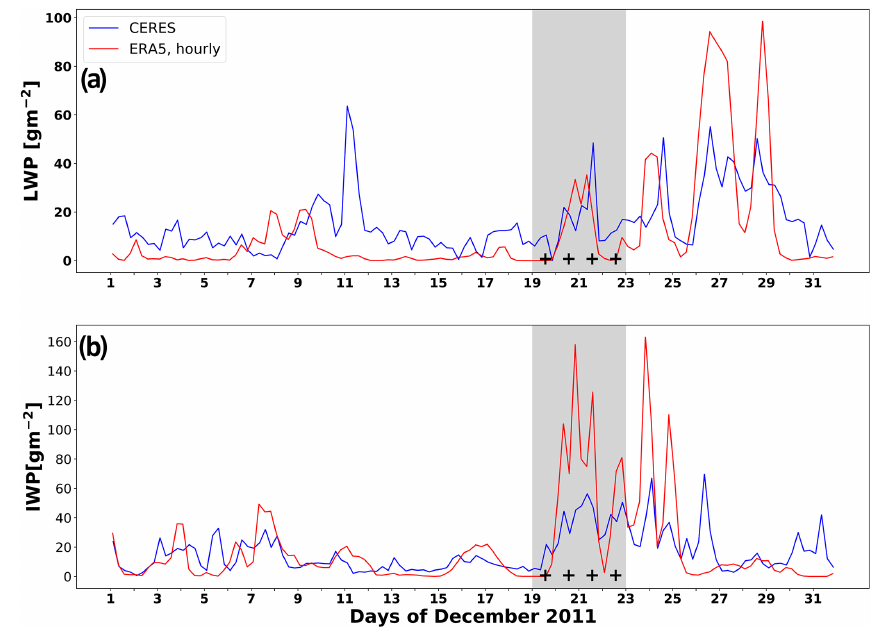
Figure 23. As in Fig. 5 but over the RIS region containing the Tom and Sabrina AWSs throughout December 2011.